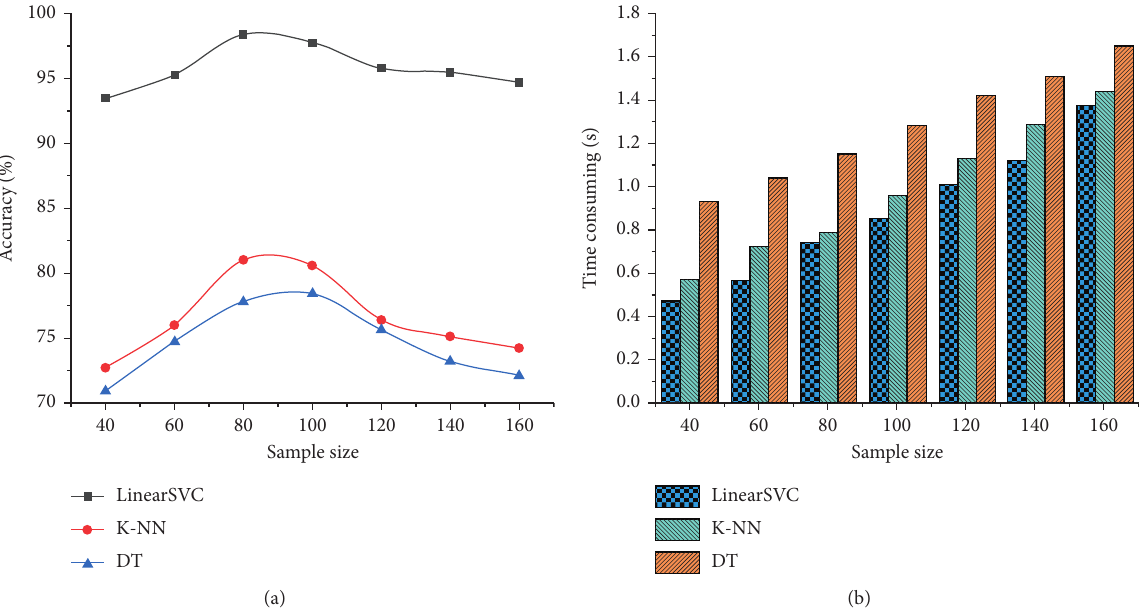
Figure 7: The relationship between different number of training samples and accuracy and time. (a) Accuracy line graph. (b) Modeling time diagram.